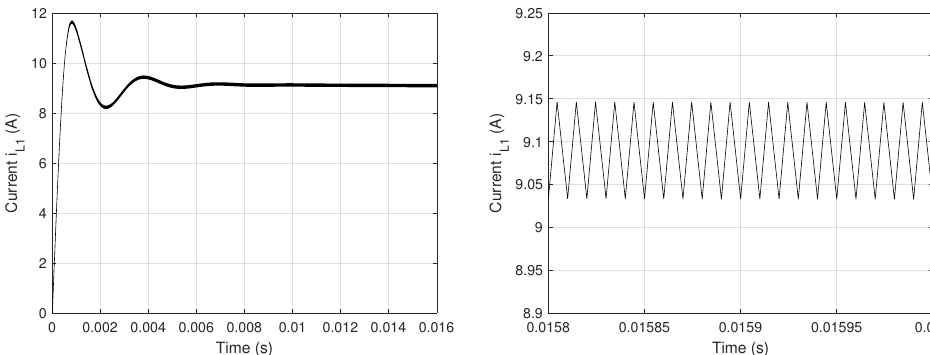
Figure 15. Time − domain waveforms for R = 2.5 Ω in faulty switching case h 1 = h 2 = 1, h 3 = 0, and with a slope